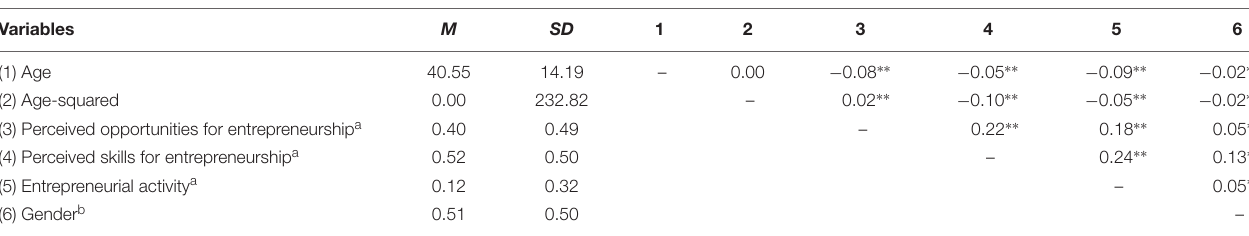
TABLE 1 | Descriptive statistics and correlations.